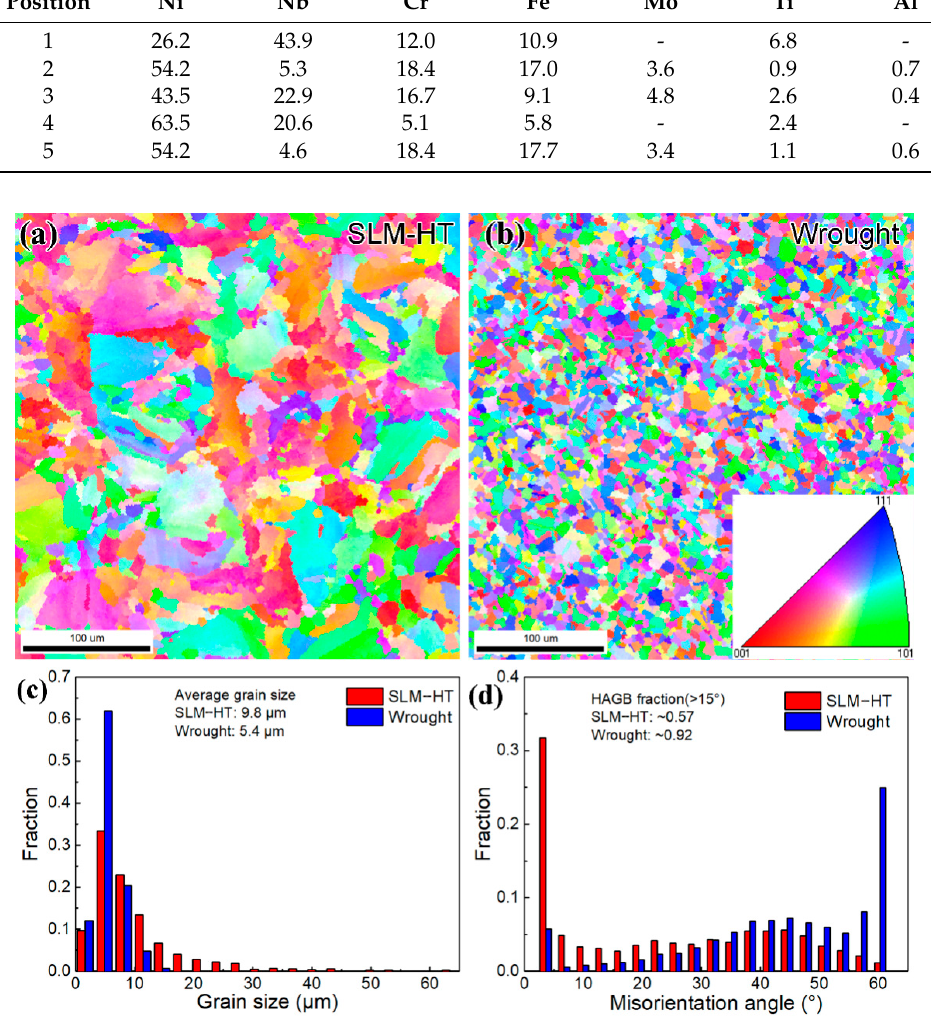
Figure 4. EBSD inverse polar figure maps of ( a ) SLM-HT and ( b ) wrought specimens, ( c ) grain size distribution and ( d ) grain boundary misorientation distribution. The scanning planes were perpendicular to the build direction for the SLM-HT specimen and the forging direction for the wrought